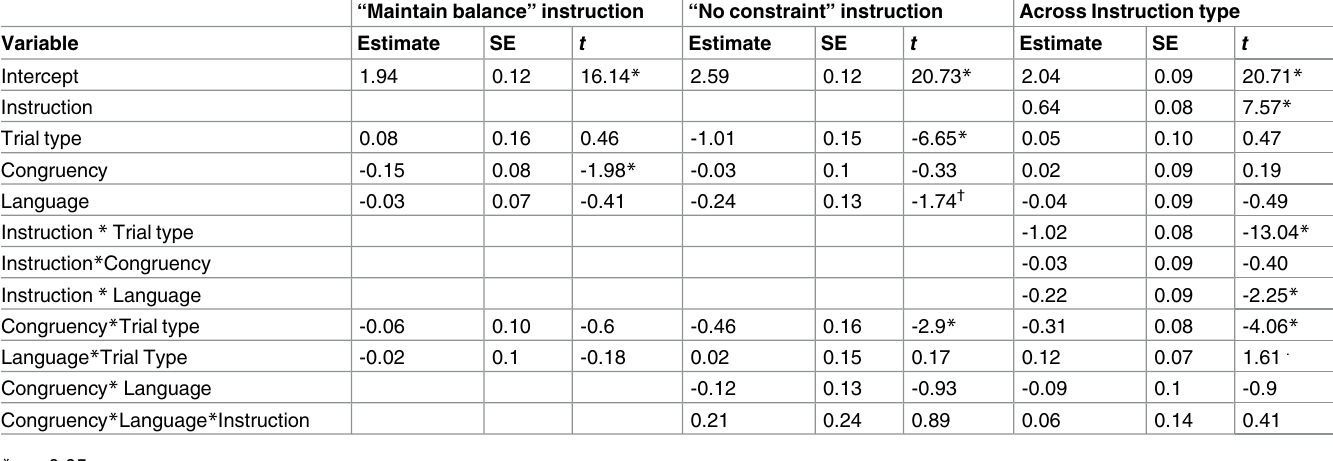
Table 2. Results on choices during the two instruction conditions derived from mixed-effect models. (Experiment 1).